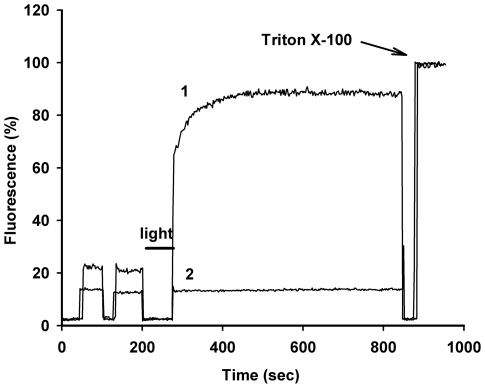
Dependence of liposome photodamage on lipid composition.SRB-liposomes made of EggPC (curve 1) or DPhPC (curve 2) were resuspended in PBS and exposed to red light in the presence of 350 nM of 5. Note SRB leakage from EggPC- but not from DPhPC-containing liposomes. Shown is one representative experiment out of three independent replicates.